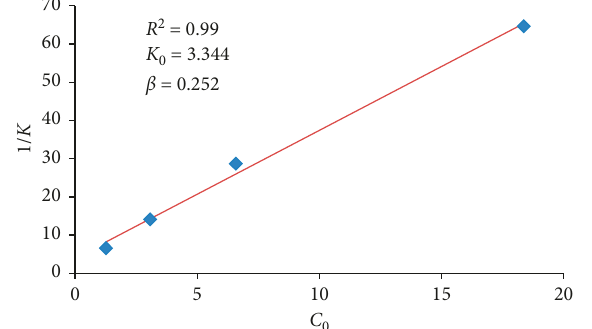
Figure 7: Linearised plot of the reaction rate constant (1/ K ) against the initial chlorine dose used ( C 0 ).